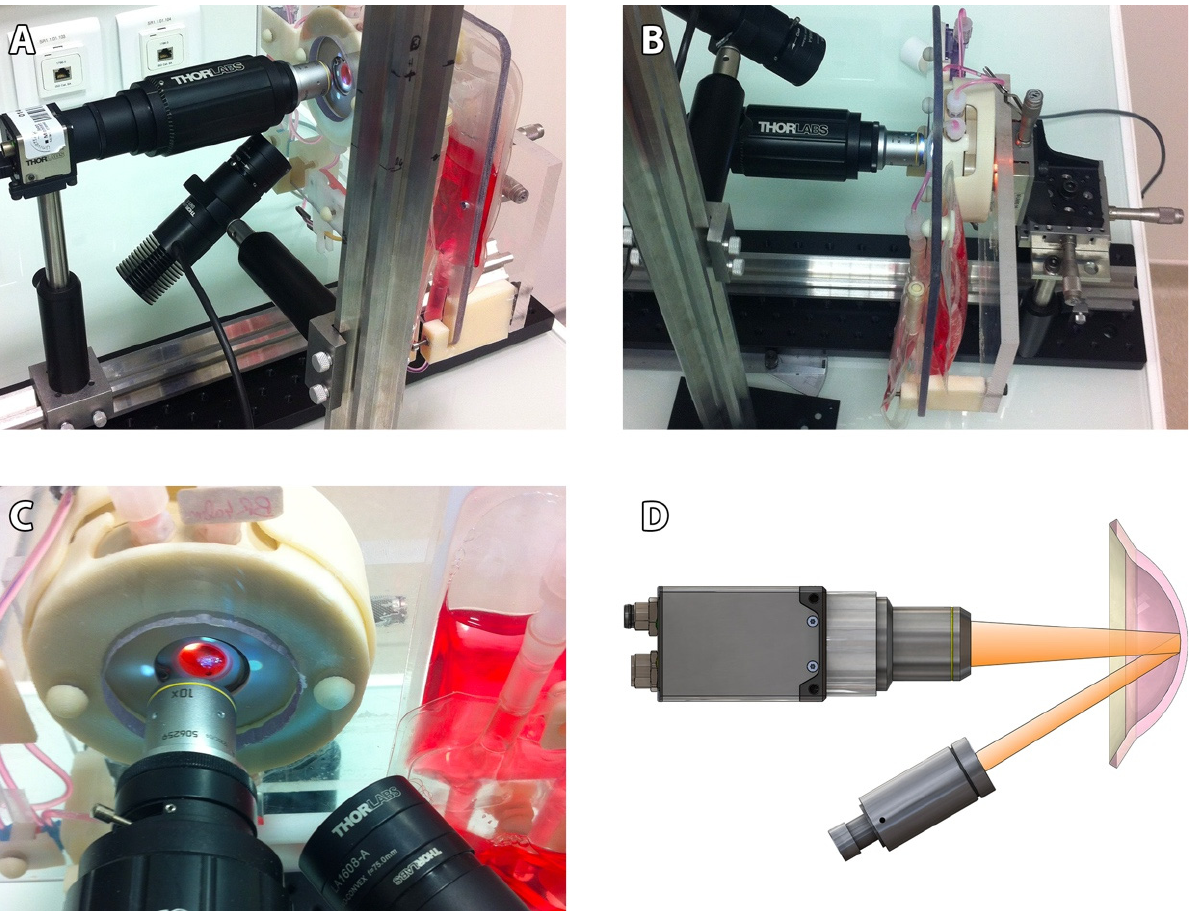
Figure 1. Custom-made specular microscope prototype adapted for our active storage machine (ASM). ( A ) General view of the optical bench, the camera and its objective, the led source, and the 3D-printed support intended to receive the ASM. Note the working distance, the collimated source, and the diaphragm produce a light beam focused on endothelial side of the cornea. ( B ) The ASM could be moved precisely thanks to the micrometric translation XYZ stage. ( C ) Close-up view, with one quadrant. ( D ) Schematic view of specular reflection from endothelial side of the cornea. The collimated source illuminated a corneal area, and the camera recorded the specular reflection.